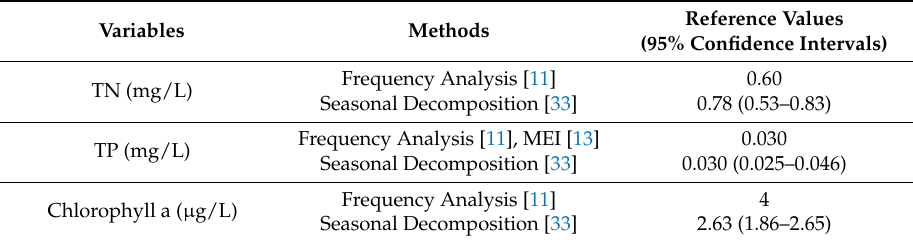
Table 4. The recommended reference conditions by previous